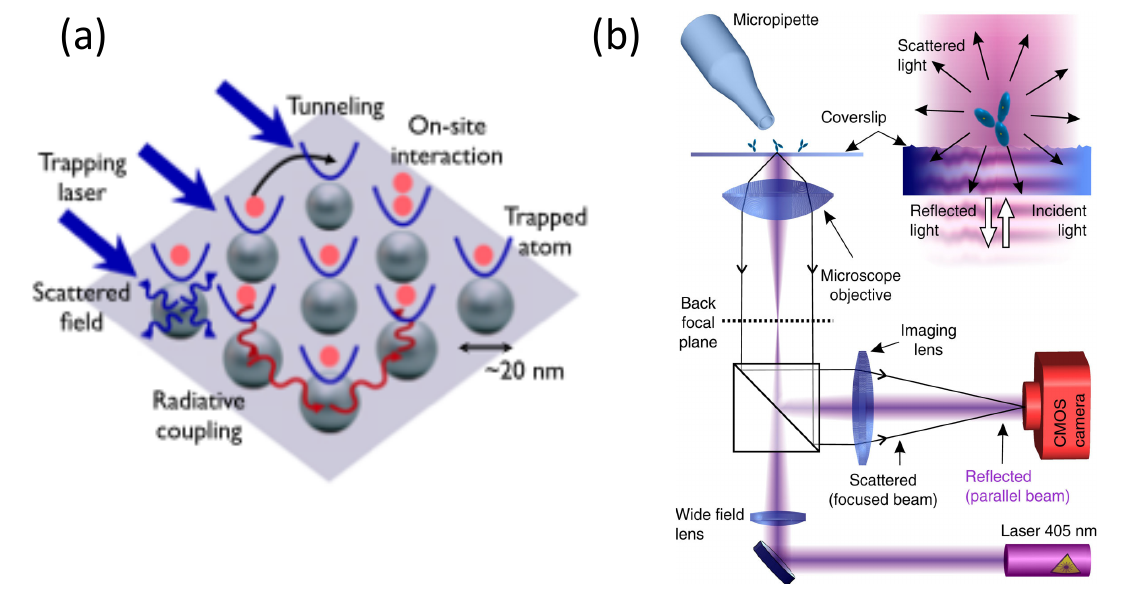
Figure 5. Future opportunities for POT. ( a ) Physical processes involved in atomic trapping in a nanoplasmonic optical lattice. Reproduced with permission from [63]. Copyright 2012, American Physical Society. ( b ) Interferometric scattering microscopy (i-SCAT) for label-free detection of single molecules. Reproduced with permission from [65]. Copyright 2012, Nature Publishing